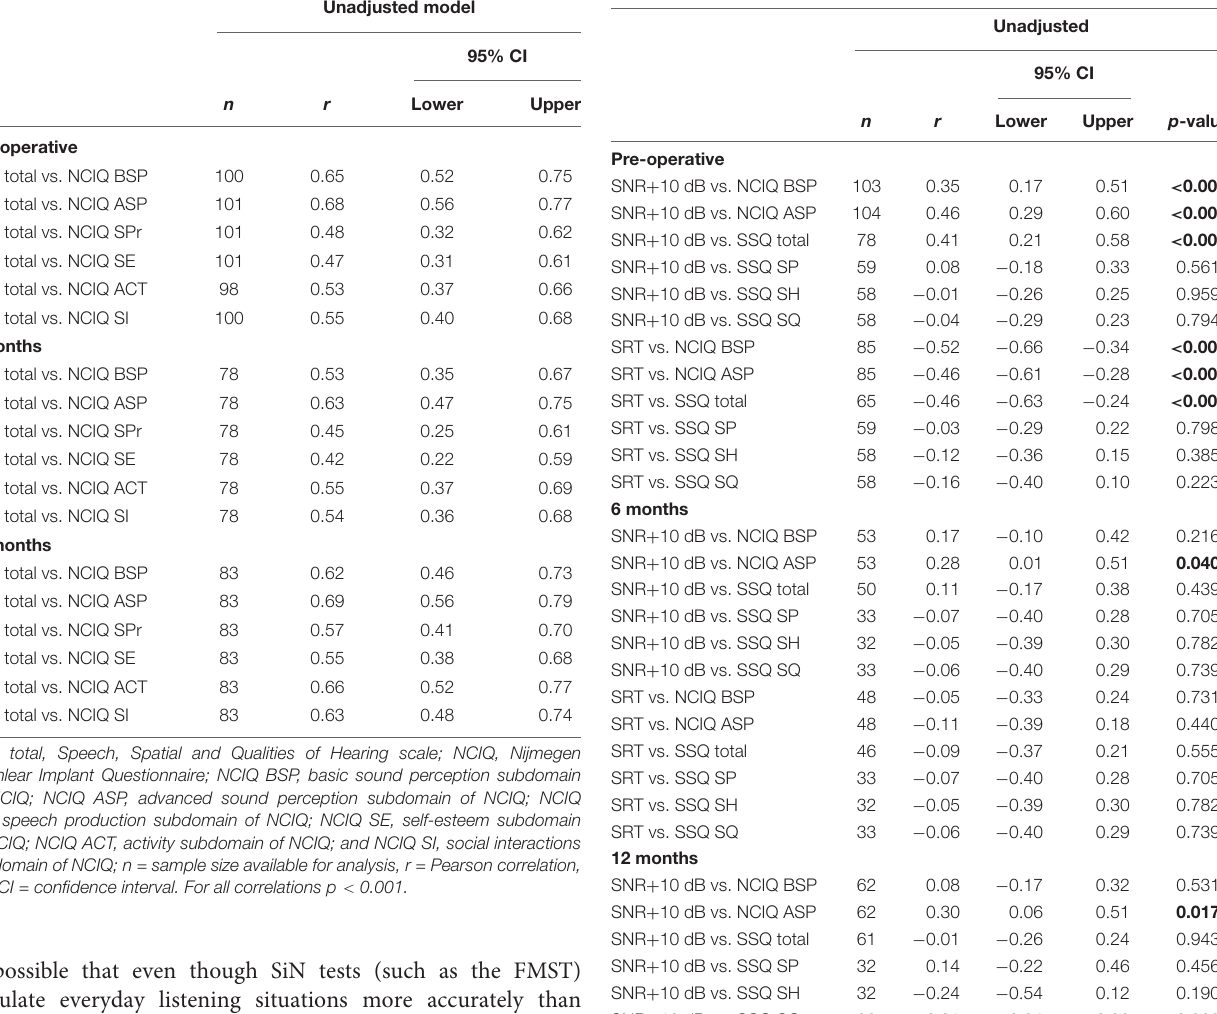
Unadjusted 95% CI